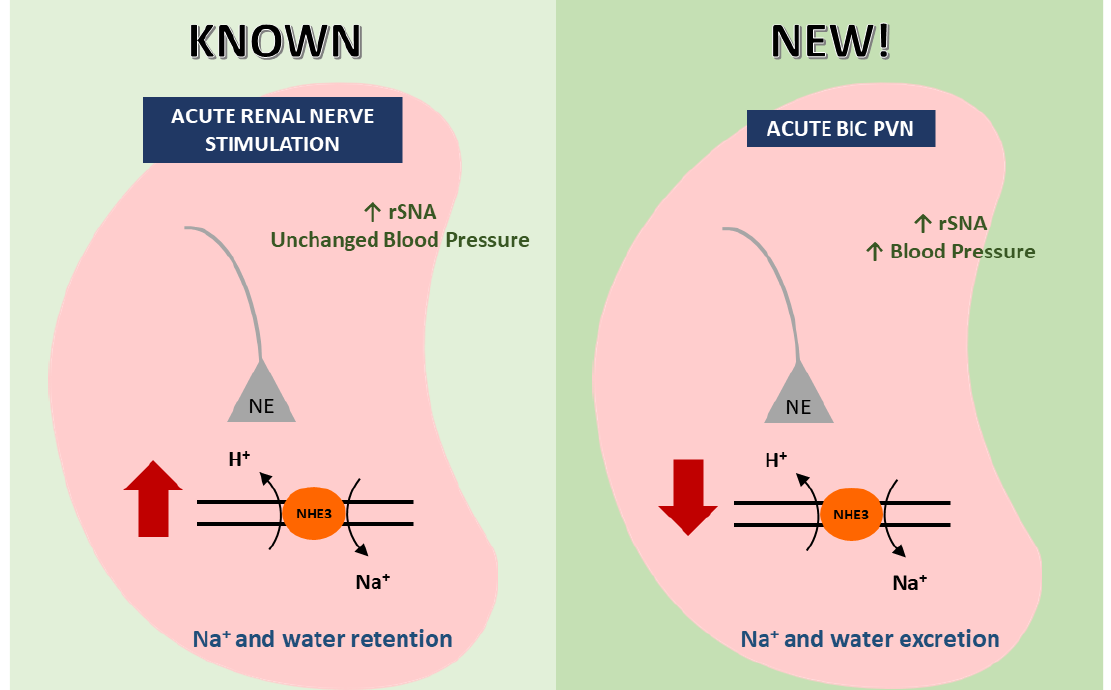
Figure 6. Schematic representation on the left of the figure shows increased NHE3 activity during selective renal nerve stimulation leading to increased sodium and water retention as previously reported [8]. On the right of the figure, shows that the renal nerve stimulation accompanied by in- creased blood pressure during PVN activation leads to reduction of NHE3 activity and conse- quently, increased salt and water